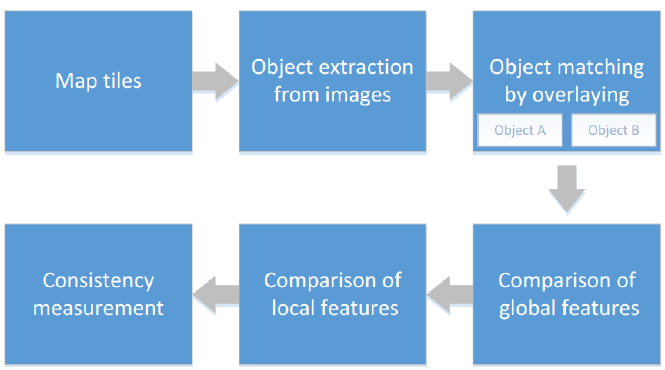
Figure 3. Framework for measuring consistency.